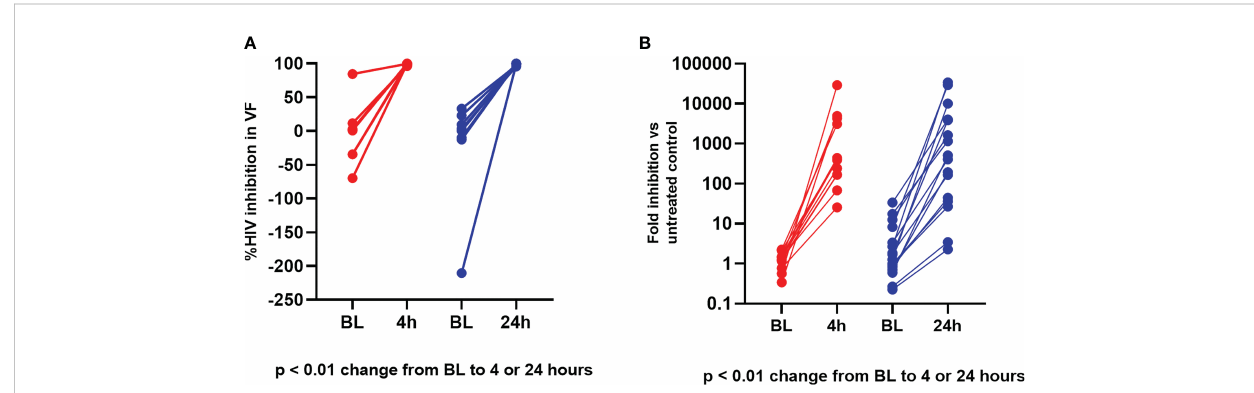
FIGURE 4 Ex vivo PD modeling of anti-viral effect in vaginal fl uid. (A) Vaginal Fluid HIV-1 Inhibition. Red = Baseline (BL) to 4 hours; Blue = Baseline to 24 hours. (B) Vaginal Fluid HSV-2 Inhibition. Red = Baseline (BL) to 4 hours; Blue = Baseline to 24 hours.